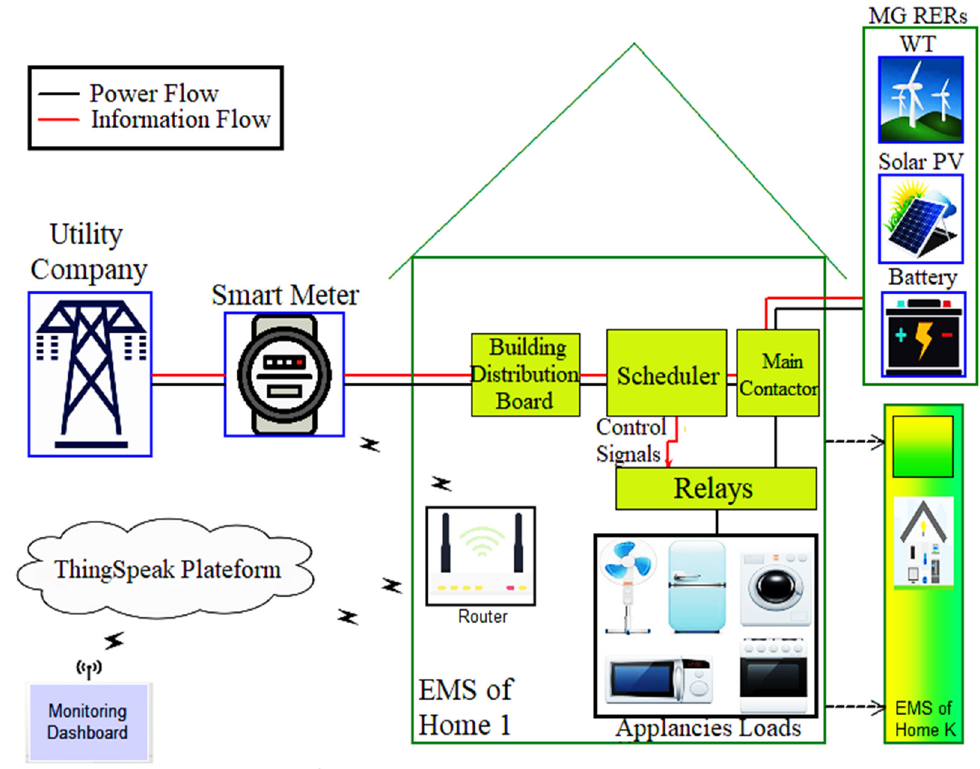
Figure 2. Graphical representation of the proposed model.